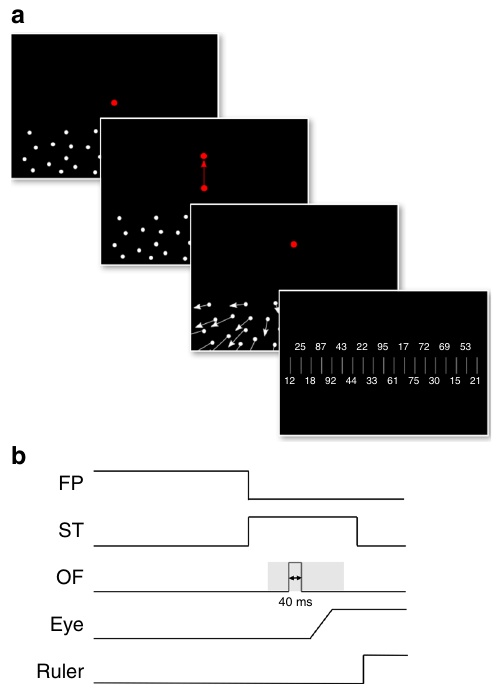
Fig. 8 The paradigm for testing perceived heading in humans. a Self-motion stimuli as well as fi xation and saccade targets were generated with the Psychtoolbox 54 and back-projected via a video projector onto a tangent screen covering the central 81 × 65 º of the visual fi eld. Across trials, simulated self-motion was pseudo-randomized in one of the fi ve directions: to the left ( − 30° and − 15°), straight ahead (0°), or to the right (15° and 30°). Self-motion stimuli consisted of fi ve consecutive frames of 100% coherent dot motion, i.e., lasting 40 ms during which a total forward displacement of 3.3 m was simulated. Each trial started with presentation of the fi xation target and the stationary ground-plane stimulus. After 1600 – 2000 ms, the fi xation target was switched off and the saccade target was switched on (until the end of the trial), inducing a visually guided vertical saccade of 10°. Across trials, the onset of the self-motion stimulus ranged from about 200 ms before to 200 ms after saccade onset. At the end of each trial, the saccade target and the ground plane stimulus were switched off and a ruler with a random sequence of numbers was presented on the screen. Ruler ticks were separated by 1°. Subjects had to indicate via keyboard input the number on the ruler that appeared closest to their perceived heading direction. Pressing the return button, started a new trial. b The panel shows schematically the timing of all